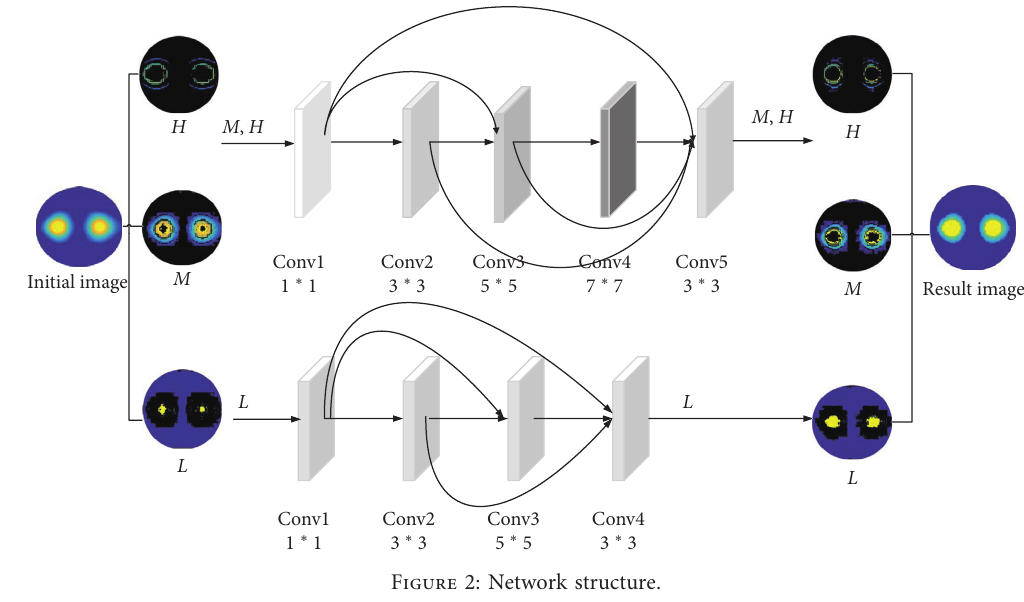
Figure 2: Network structure.